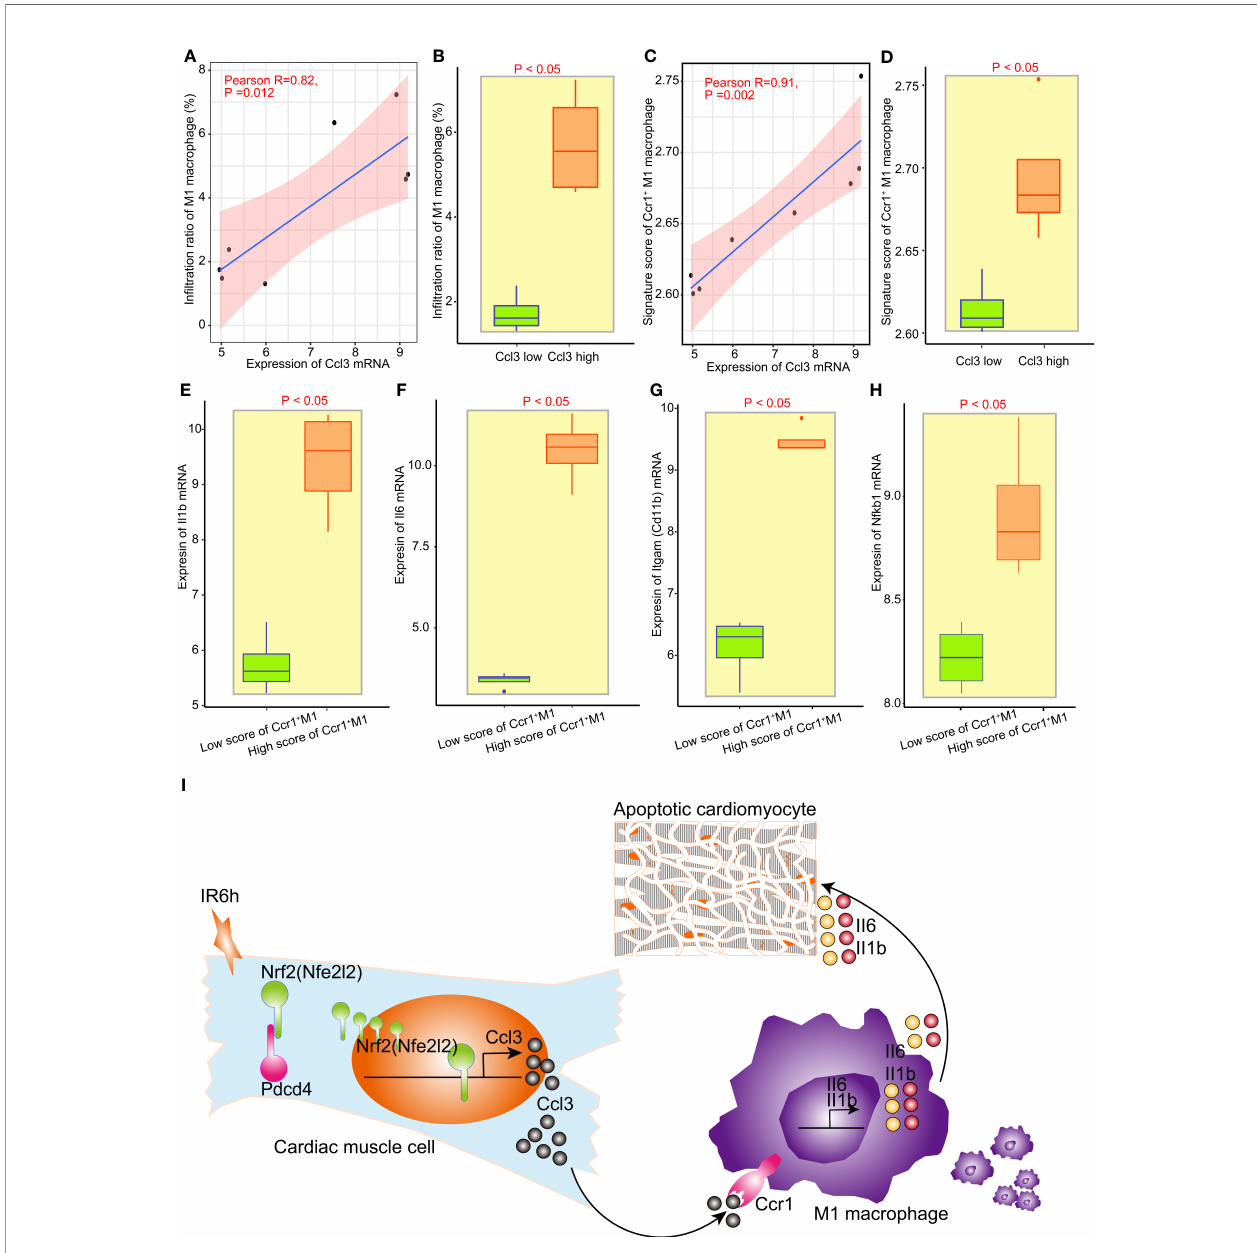
FIGURE 5 | Nrf2 promoted the in fi ltration of M1 macrophages and release of in fl ammatory factors via initiating the transcription of Ccl3. (A) Correlation analysis between Ccl3 expression and M1 macrophage in fi ltration. (B) Analysis of in fi ltrated M1 macrophages between the low Ccl3 and high Ccl3 groups. (C) Correlation analysis between Ccl3 expression and the signature score of Ccr5 + M1 macrophages. (D) signature score of Ccr5 + M1 macrophages between the low Ccl3 and high Ccl3 groups. (E – H) The expression of in fl ammatory factors II1b, II16, Nfkb1, and macrophage labeling Cd11b between the low-score Ccr5 + M1 macrophage signature group and the high-score Ccr5 + M1 macrophage signature group. (I) Schematic diagram of Nrf2, cooperated with PDCD4, promoting the in fi ltration of M1 macrophages and release of in fl ammatory factors by initiating the transcription of Ccl3 in early myocardial ischemia